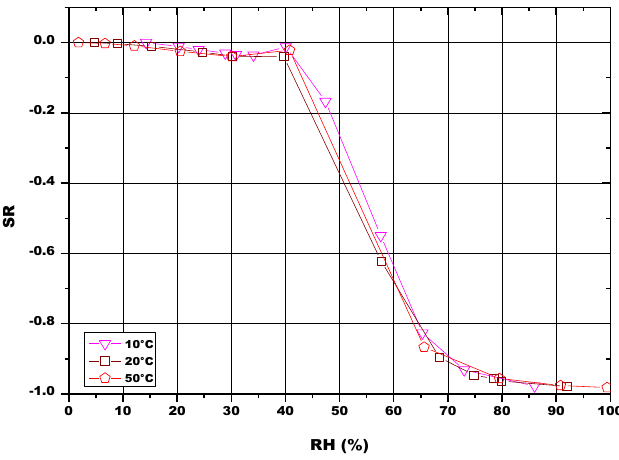
Figure 12. SR of the 5% SrO sensor (pellet) fired at 900 °C in function of RH, tested under different working